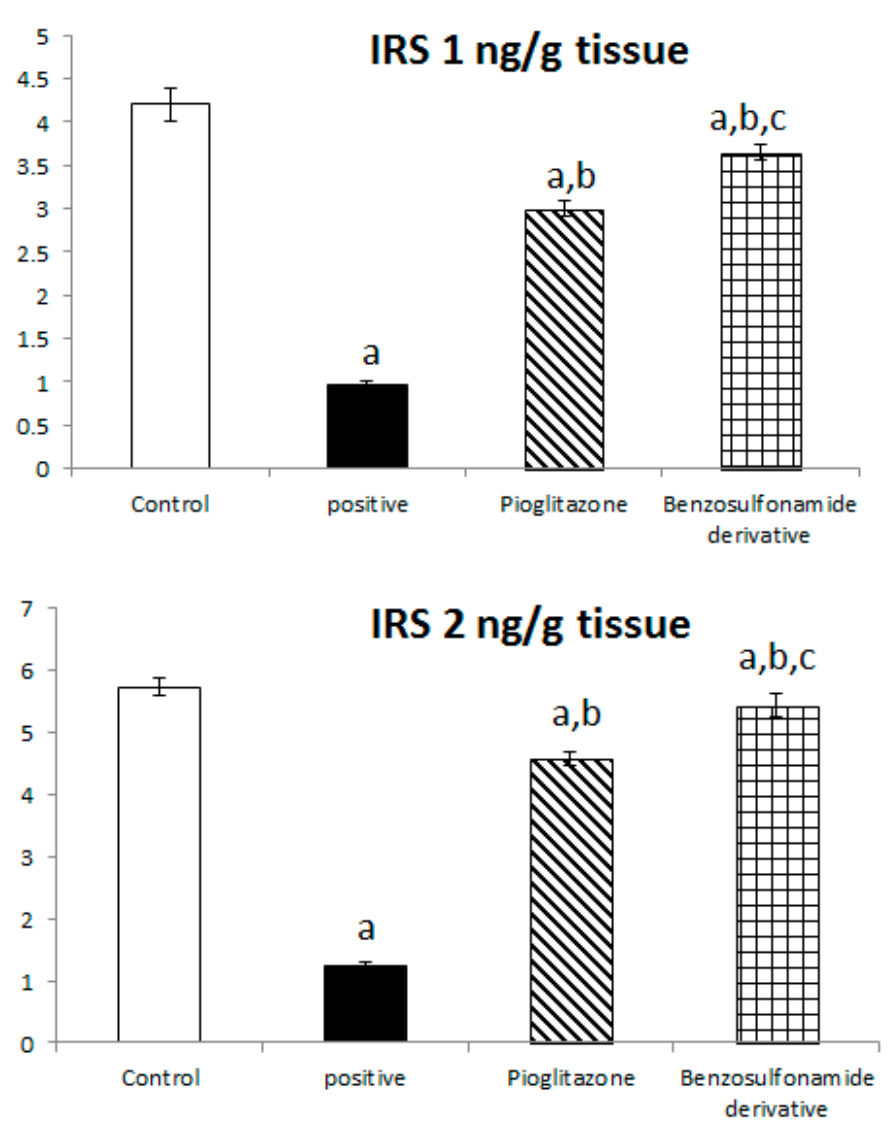
Figure 3. Bar chart presentation of liver tissue IRS-1 and IRS-2 concerning the effect of 14 days of oral administration of the synthetic compound against reference anti-hyperglycemic pioglitazone on STZ-induced type 2 DM. DM: diabetes mellitus. Each bar represents the mean of 6–8 values ± the standard error of the mean (S.E.M). a: Significantly different from the normal control group, b: Significantly different from the positive control group, c: Significantly different from the pioglitazone group at p < 0.05.